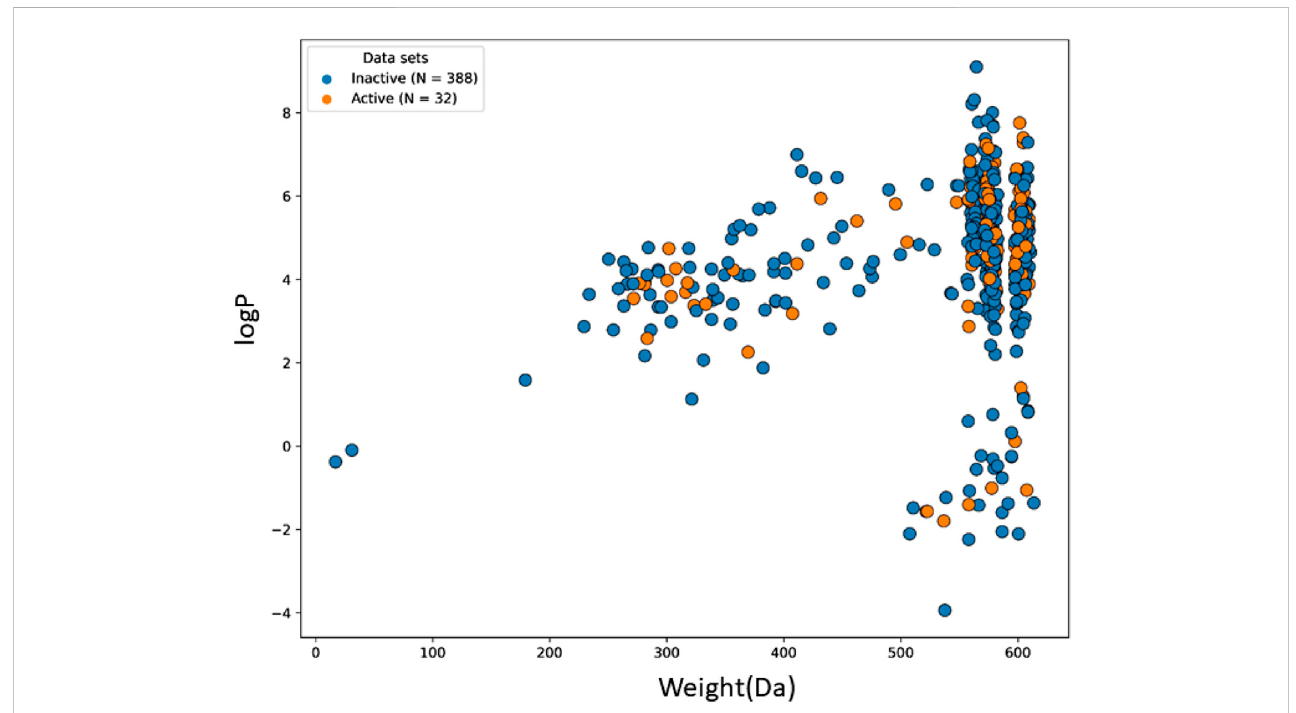
FIGURE 3 The chemical space and diversity distribution of the train set. The molecular weight and LogP de fi ne the chemical space.